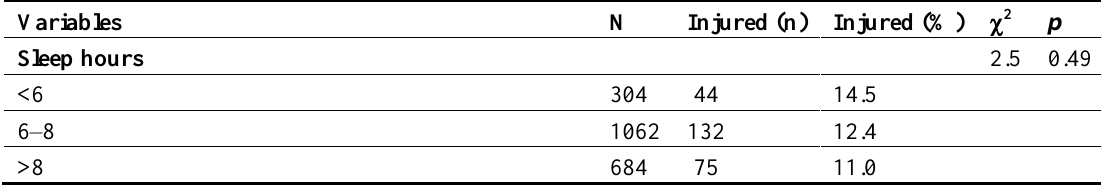
Table 3. Association between sleep-related variables and agricultural work-related injuries among farmers in a northeastern province,